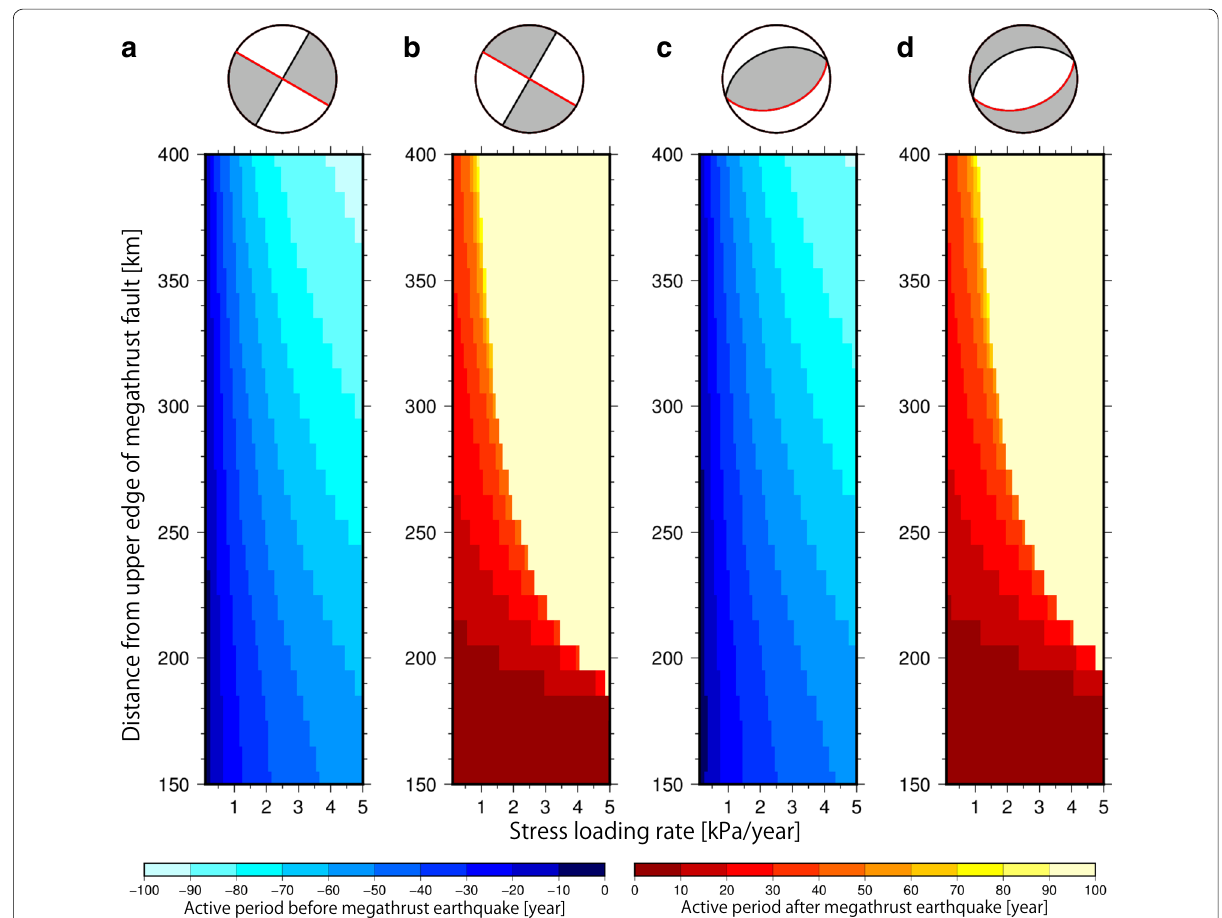
Fig. 4 Active period depending on the distance and the intrinsic loading rate for each fault type. The red nodal planes on the beach ball diagrams depict the fault plane for calculating the active period. a Dextral fault, b sinistral fault, c reverse fault, and d normal